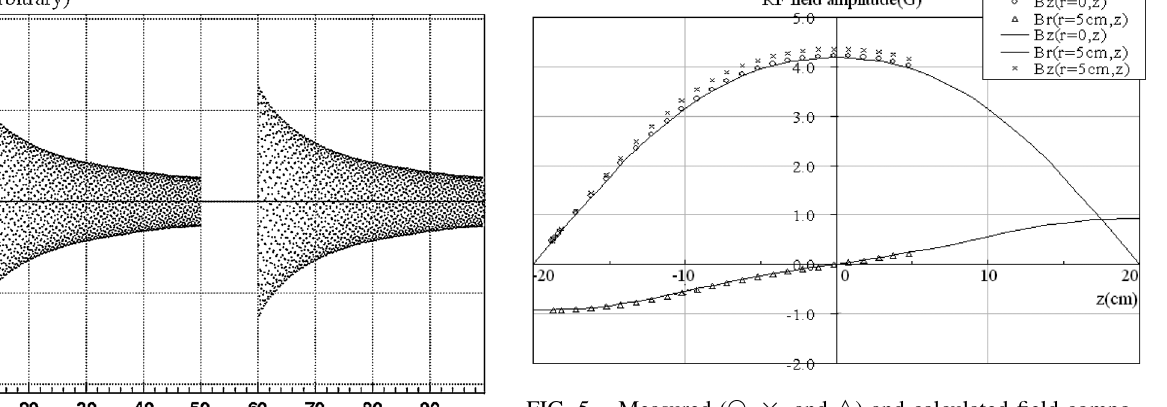
FIG. 5. Measured ( (cid:17) , (cid:1) , and 4 ) and calculated field compo- (cid:5) r (cid:4) 0 cm ; z (cid:6) , B (cid:5) r (cid:4) 5 cm ; z (cid:6) , and nents (solid lines) for B z z (cid:5) r (cid:4) 5 cm ; z (cid:6) of the RFSR. The solenoid is 30 cm long and B r the RFSR, i.e., the rf field, is 40 cm long.FIG. 4. Typical reconstructed current-to-voltage signals for the